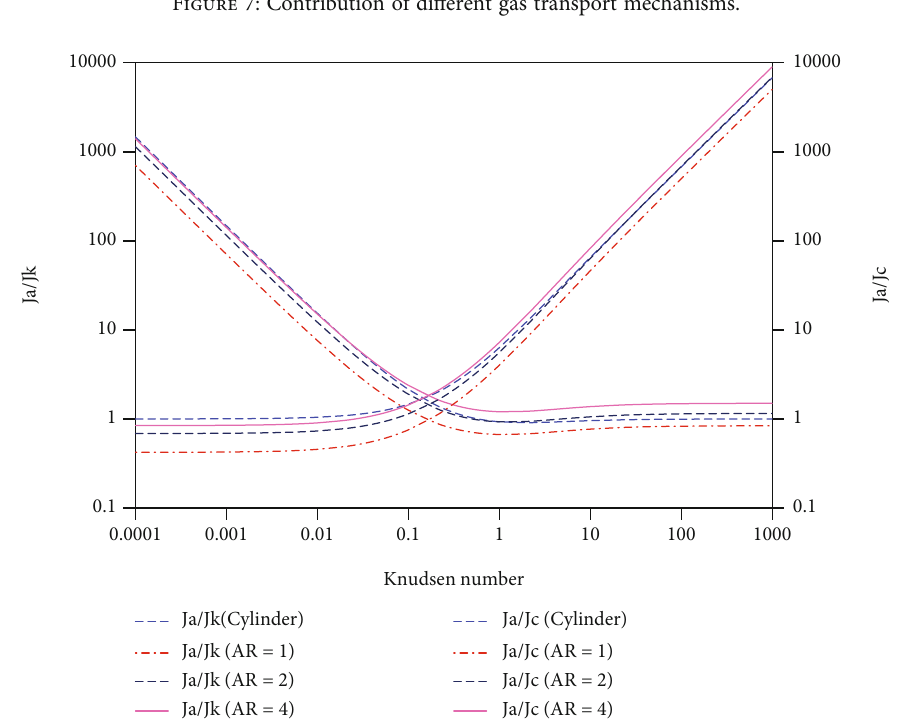
Figure 8: The bulk-gas transport capacity with di ff erent Kn